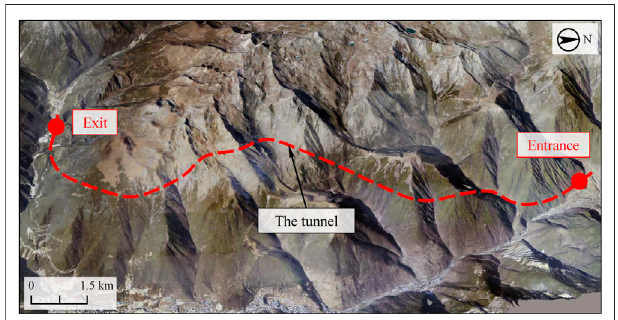
FIGURE 1 | Topographic map of the tunnel